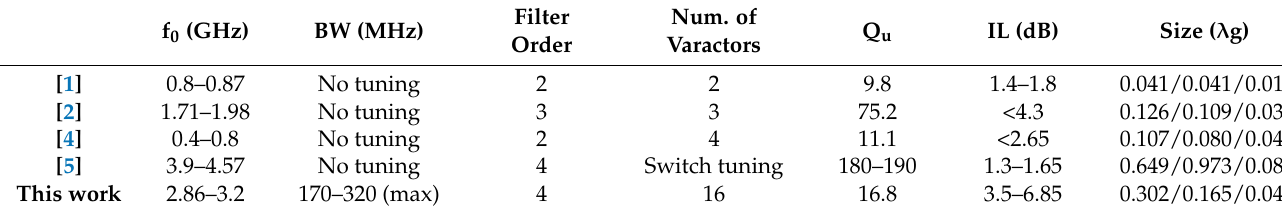
Figure 12. ( a ) The measured and simulated tuning results of the center frequency. (Red line: 2.86 GHz, Black Line: 3 GHz, Green Line: 3.2 GHz) The measured and simulated tuning results of BW at ( b ) 2.86 GHz, ( c ) 3 GHz, and ( d ) 3.2 GHz. (Red line: the maximum value of BW, Black Line: the minimum value of BW). Table 3. Comparison with some prior LTCC